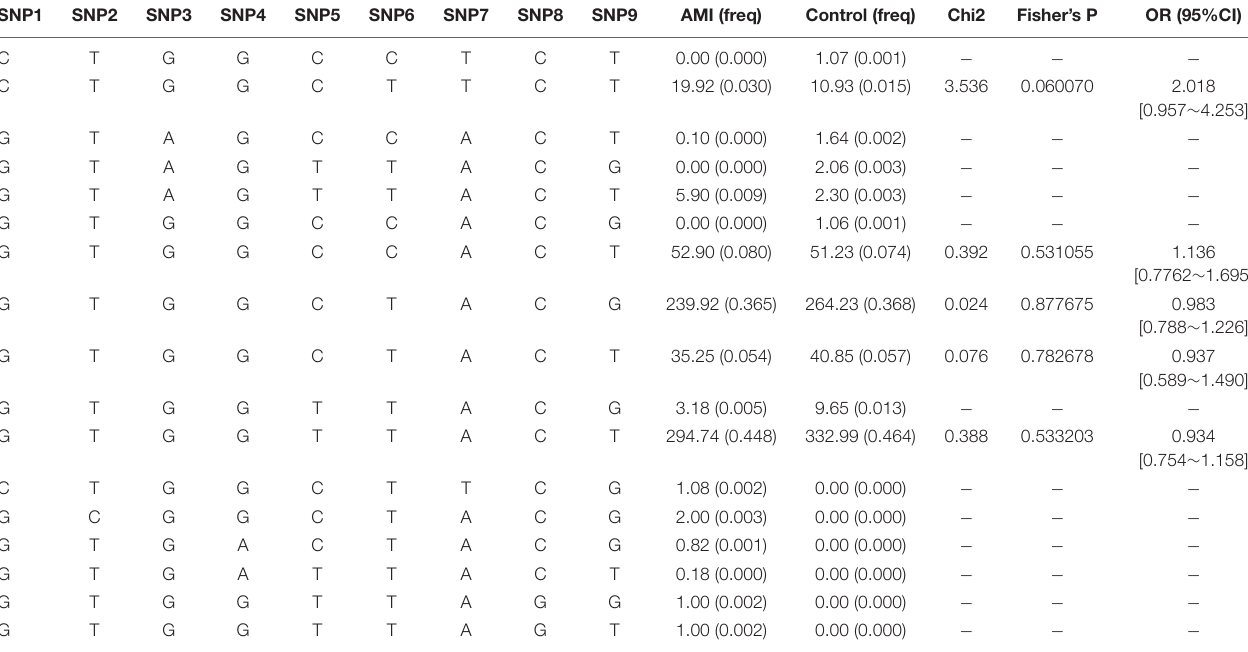
TABLE 7 | Haplotype analysis of the SNPs in the ATG16L1 promoter region and the association with AMI risk. SNP1